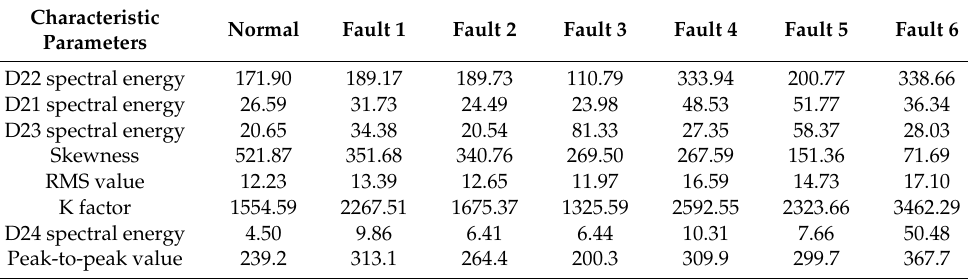
Table 5. The optimal eigenvectors for each valve state.